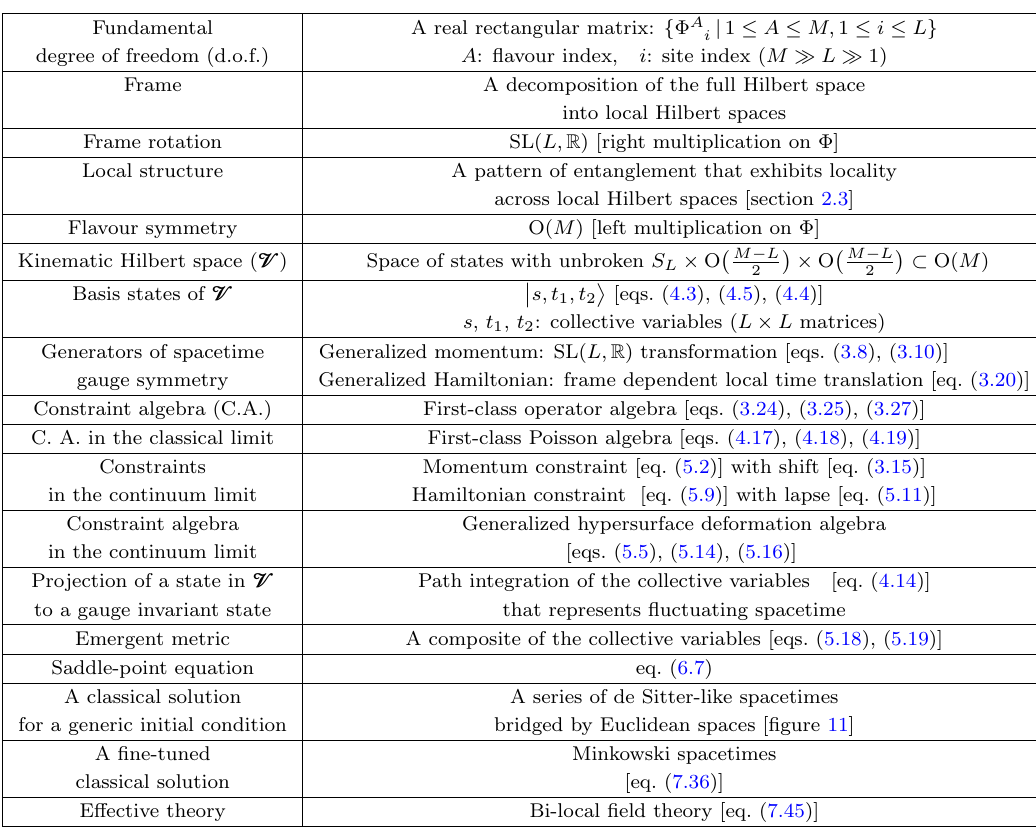
Table 1 . A roadmap of the